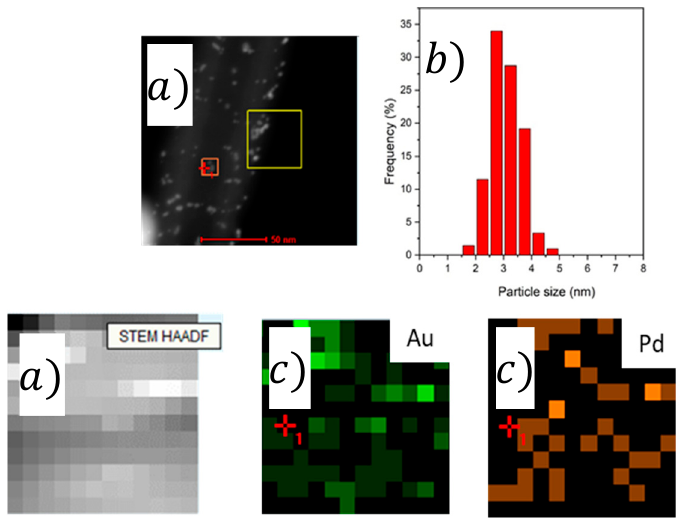
Figure 4. ( a ) TEM, ( b ) NP size distribution, and ( c ) EDX analysis of Pd 2 Au 8 catalyst. Table 2. Results of XPS survey spectra